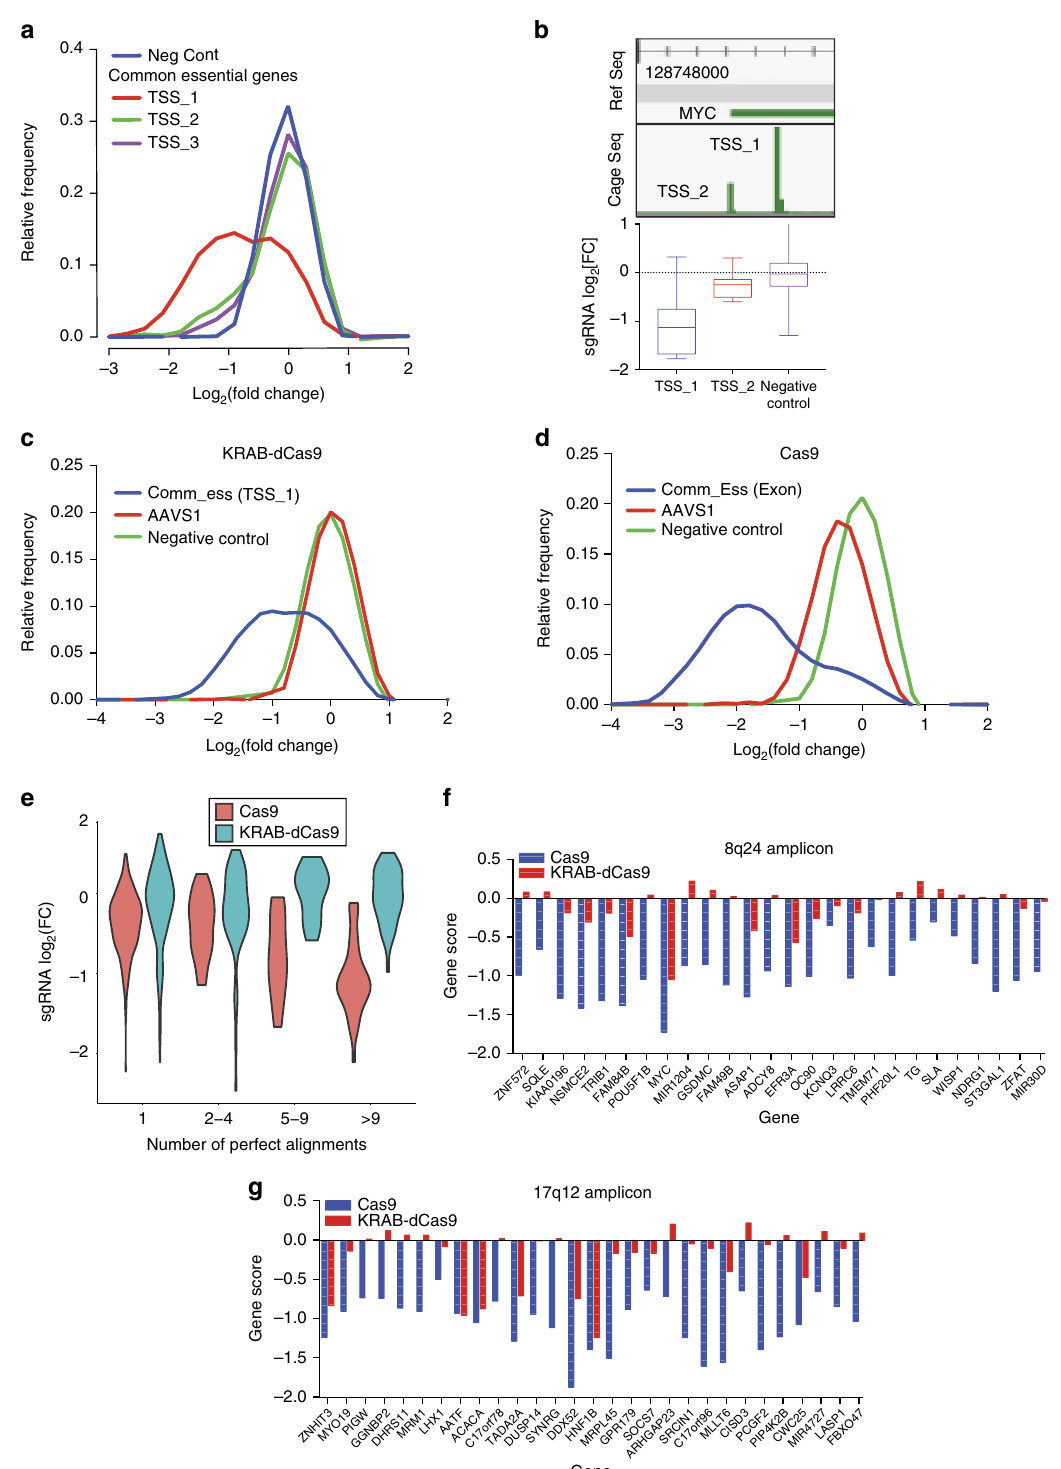
Figure 2 | Proliferation changes induced by KRAB-dCas9 are not prone to cleavage-induced toxicity. ( a ) Distribution of proliferation changes induced by sgRNAs targeting the three top cage-seq TSS of 105 cell essential genes in HT29 cells expressing KRAB-dcas9. ( b ) Proliferation changes and locations of two alternative MYC TSSs (TSS_1 and TSS_2) in HT29 cells expressing KRAB-dCas9. Error bars represent the deviation from the mean of sgRNAs targeting the indicated gene. ( c ) Distribution of proliferation changes induced by sgRNAs targeting the AASV1 genomic region in HT29 cells expressing Cas9 ( d ) Distribution of proliferation changes induced by the same AAVS1-targeting sgRNAs from c in cells expressing KRAB-dCAs9. ( e ) Violin plot showing distribution of proliferation changes induced by sgRNAs that target multiple genomic regions in Cas9 (red) or KRAB-dCAs9 (blue) expressing cells. ( f ) Proliferation changes induced by Cas9 (blue) or KRAB-dCas9 (red) following suppression of genes within the 8q24 amplicon in HT29 cells. Gene score were calculated by the mean proliferation changes induced by all sgRNAs-targeting TSS_1 (KRAB-dCas9) or exon (Cas9). ( g ) Experiment as ( f ) but targeting the 17q12 amplicon. All FCs are presented as the mean of duplicate